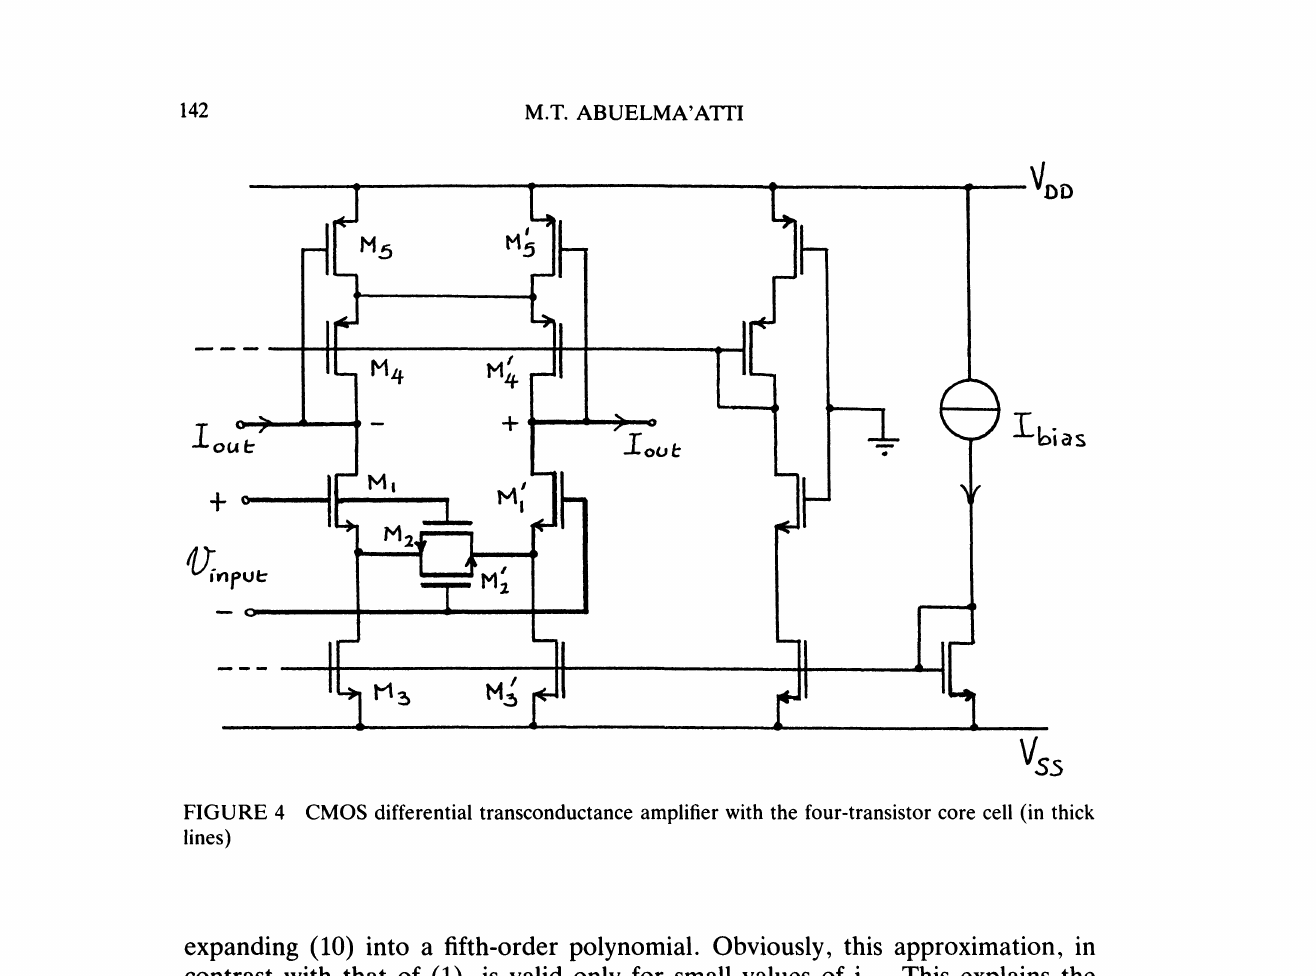
of input voltage and output